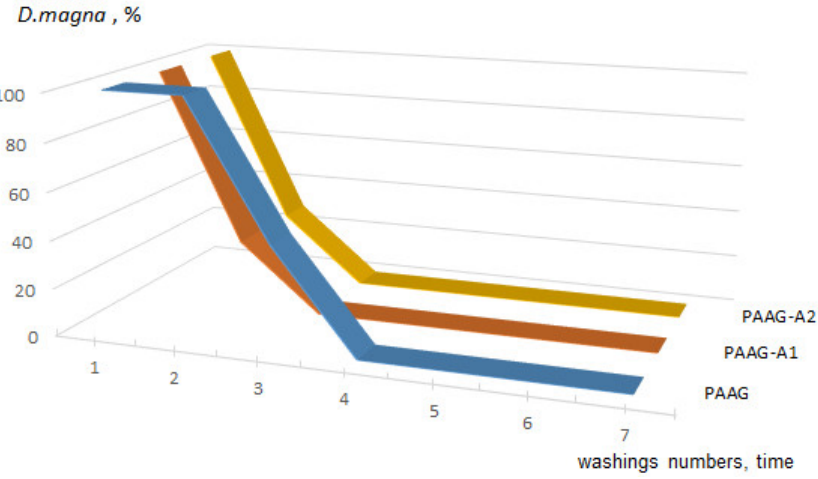
Figure 2. Dynamics of mortality of D. magna individuals depending on the number of washings: PAAG—homopolyacrylamide gel; PAAG-A1—homopolyacrylamide gel containing 5.8% raw amber; PAAG-A2—homopolyacrylamide gel containing 5.7% amber crumb. Table 2. Overall risk assessment of toxic compounds present in washing waters on the viability of biomarkers of plant (legume) and animal ( D. magna ) origin.